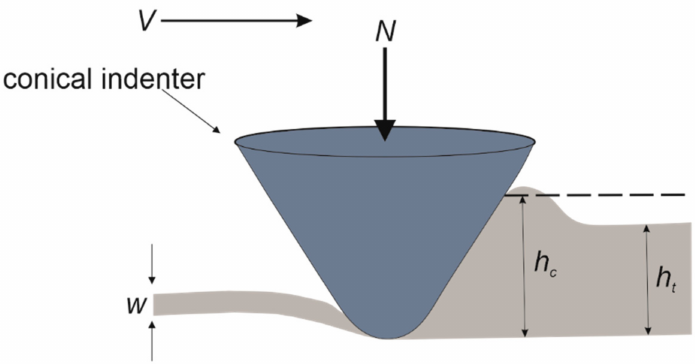
Figure 1. Schematic of deformation during the scratch